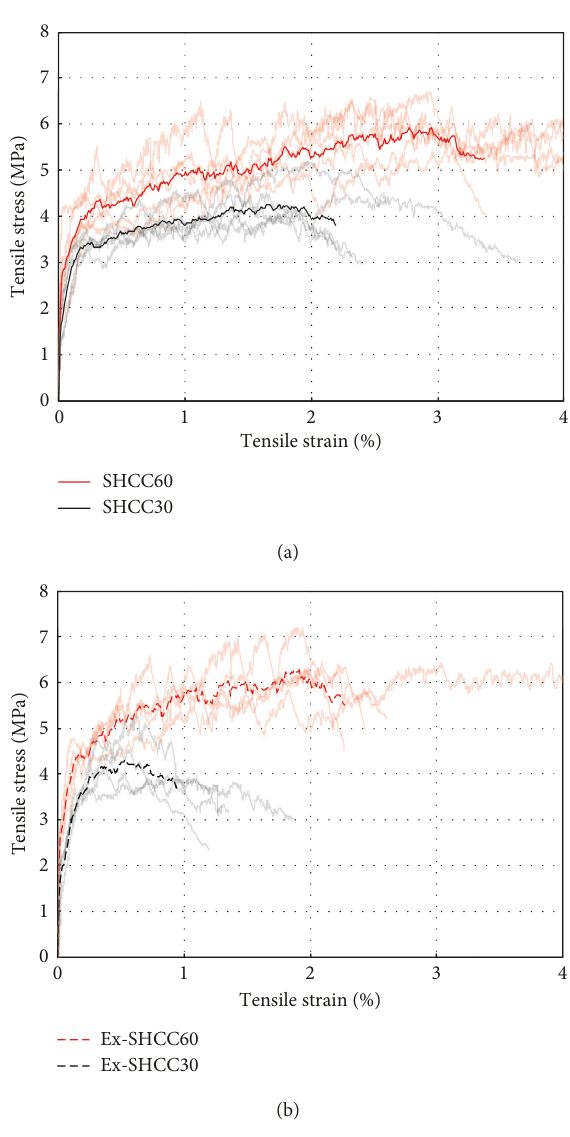
Figure 4: Effects of expansive admixture on tensile responses of SHCC and Ex-SHCC mixtures. (a) SHCC mixtures. (b) Ex-SHCC